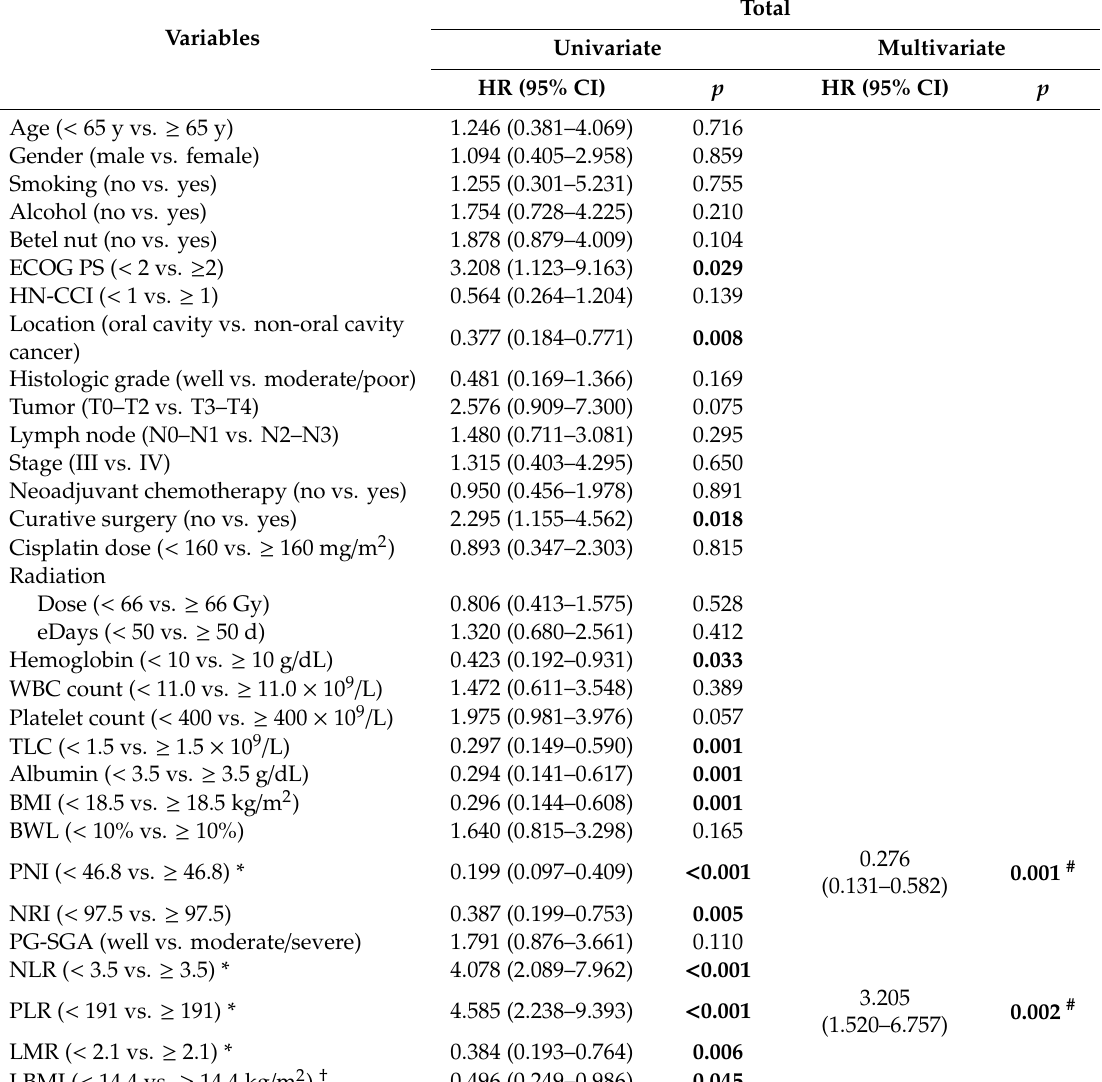
Table 2. Univariate and multivariate analyses of factors associated with 1 year mortality of LAHNC patients undergoing